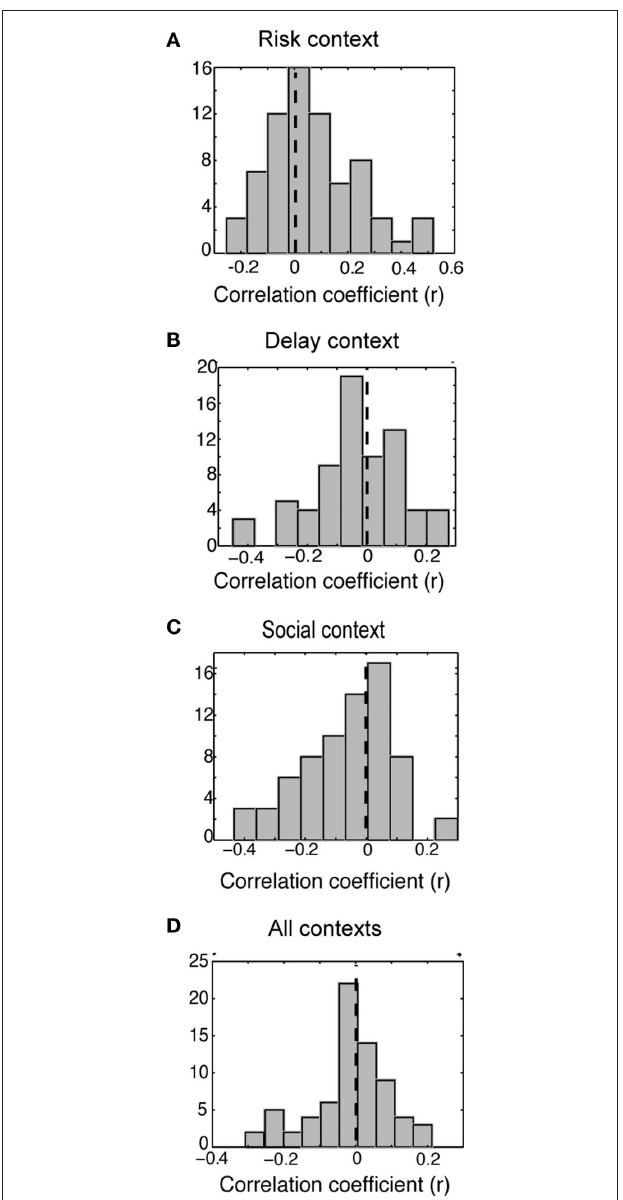
Figure 5 | The Cgp population does not encode value independent of context. Histogram of correlation coefficients for subjective value (see Materials and Methods) for the: (A) Risk context. (B) Delay context (C) Social valuation context. (D) All contexts